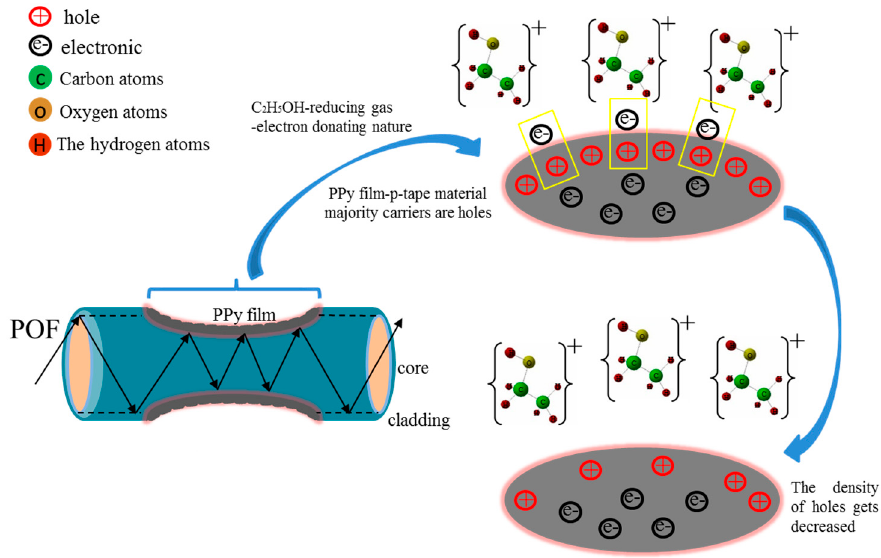
Figure 1. The schematic diagram of the proposed sensor.